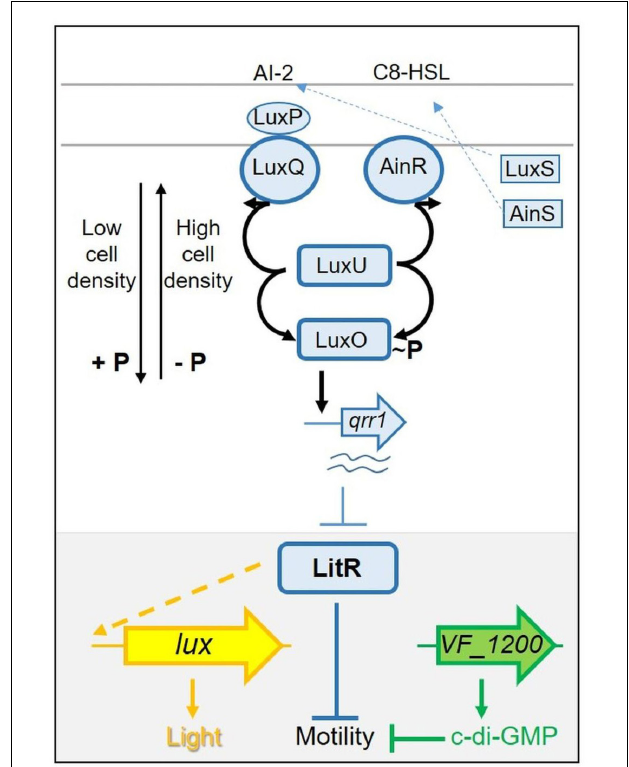
FIGURE 1 | Simplified pathway(s) controlling light production and motility in Vibrio fischeri . LitR (blue, in gray-highlighted region at bottom of figure) is a central regulator controlling both luminescence and motility. LitR indirectly (indicated by dashed line) activates transcription of the seven gene lux operon (shown as a single arrow in yellow) and light production. LitR also controls motility in an as-yet-unknown way. Control of LitR production occurs, in part, via a complex “quorum sensing” pathway (shown at top). At low cell density, sensor kinases LuxQ and AinR function as kinases, directing the flow of phosphate via LuxU to LuxO, activating it to promote transcription of qrr1 . The resulting small RNA inhibits LitR production. At high cell density, levels of the autoinducers (pheromones) AI-2 and C8-HSL build up and switch the activity of LuxQ and AinR from kinases to phosphatases, reversing the flow of phosphate and de-activating LuxO, allowing LitR to be produced. This model is based on ES114. In KB2B1, motility is also controlled by VF_1200 (green), which encodes a diguanylate cyclase predicted to make the second messenger c-di-GMP. This small molecule is known to inhibit motility in ES114 and other